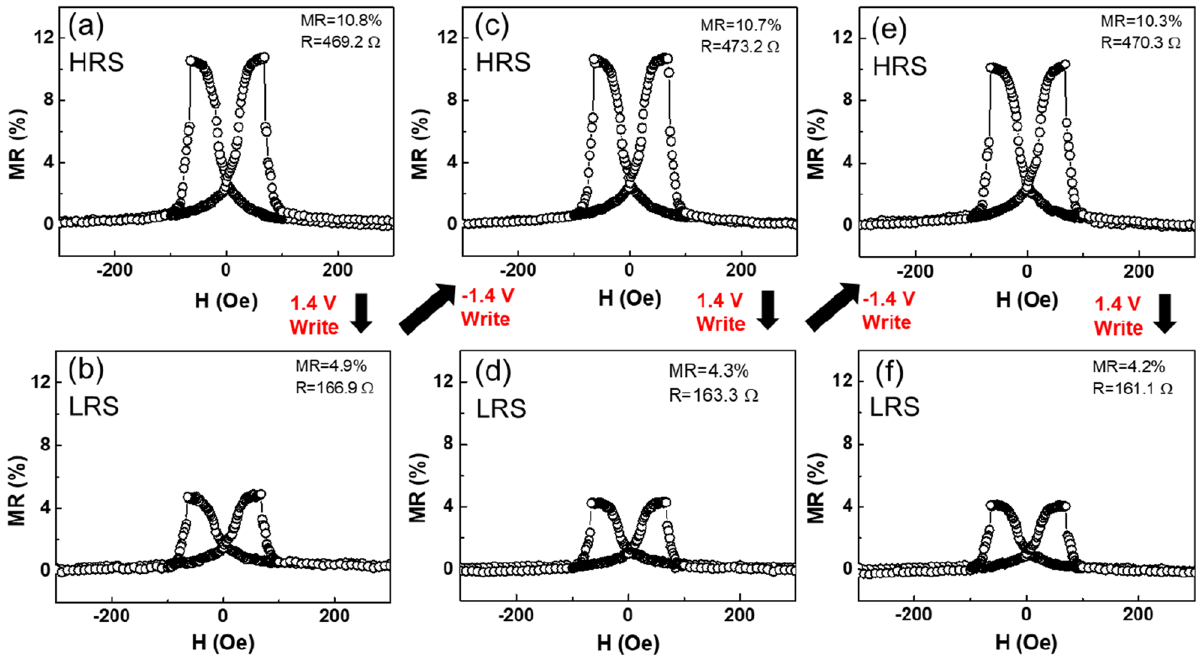
Figure 2. Sequential measurements of magnetoresistance of the reported MTJ sample. Pre-applied bias voltages and the sequence for setting the resistance states are indicated by red letters and black arrows in between the graphs whereas the MR measurements were carried out at 5 mV. The bias of 1.4 V (− 1.4 V) sets the device to LRS (HRS) where lower (higher) MR is